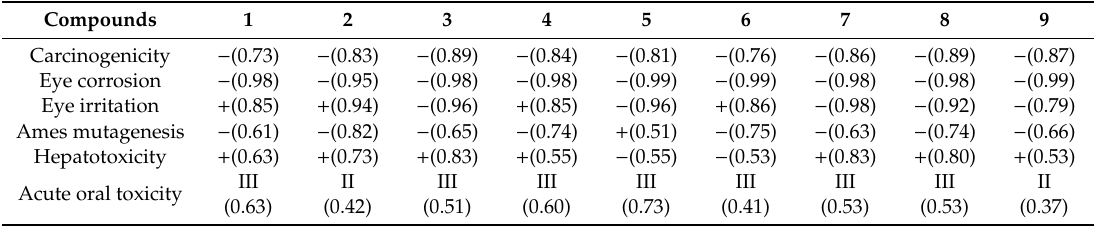
Table 3. Toxicity prediction for compounds